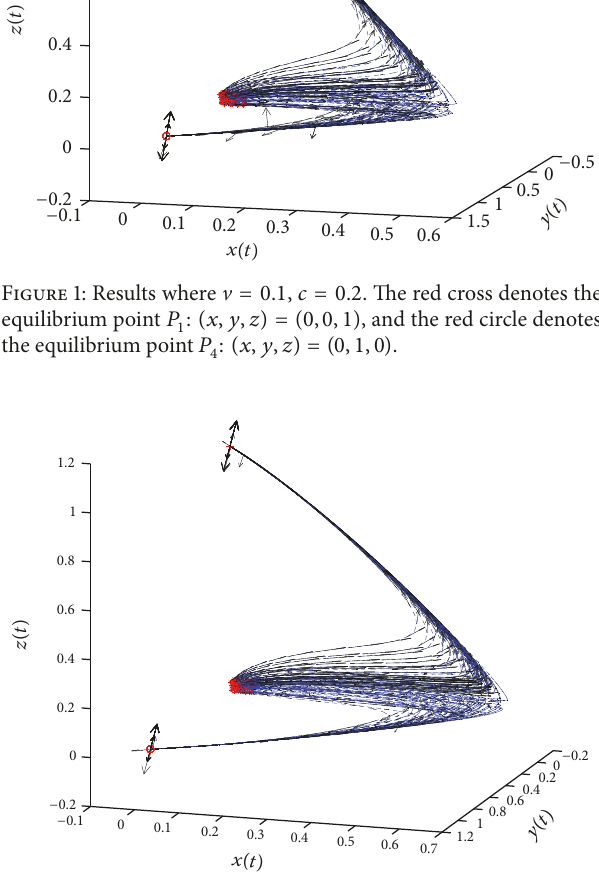
Figure 2: Results where V = 0.2 , 𝑐 = 0.3 . The red cross denotes the equilibrium point 𝑃 1 : (𝑥,𝑦, 𝑧) = (0, 0,1) , and the red circle denotes the equilibrium point 𝑃 4 : (𝑥,𝑦,𝑧) = (0,1,0) .